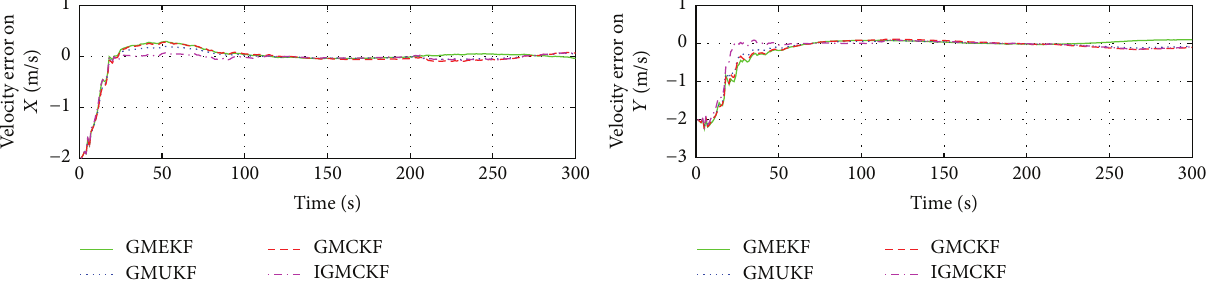
Figure 6: The curve of velocity error.